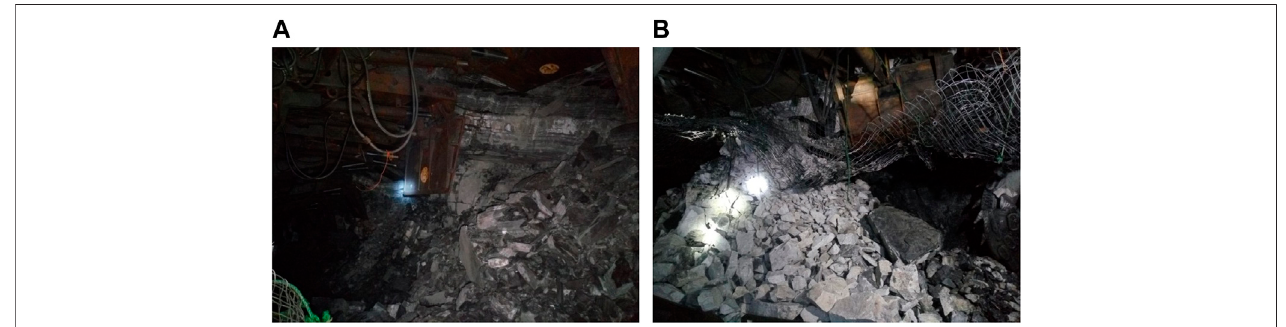
FIGURE 13 | Status of 103 fully mechanized top coal caving face. (A) Serious coal spalling. (B) Roof crushing and gangue leakage.